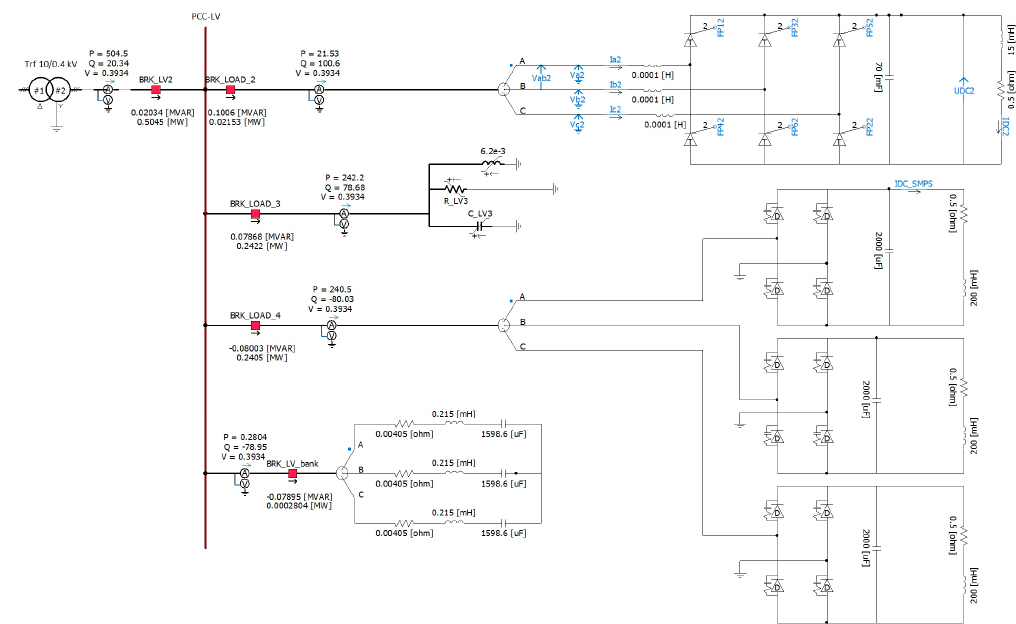
Figure 5. Detailed model of the customer’s side grid behind the MV-LV transformer (Point of Common Coupling–PCC). Along with the linear load components, a three-phase constant current converter (LOAD_2), three single-phase diode bridge rectifier connected loads (LOAD_4) and a capacitor bank (LV_bank) are added.